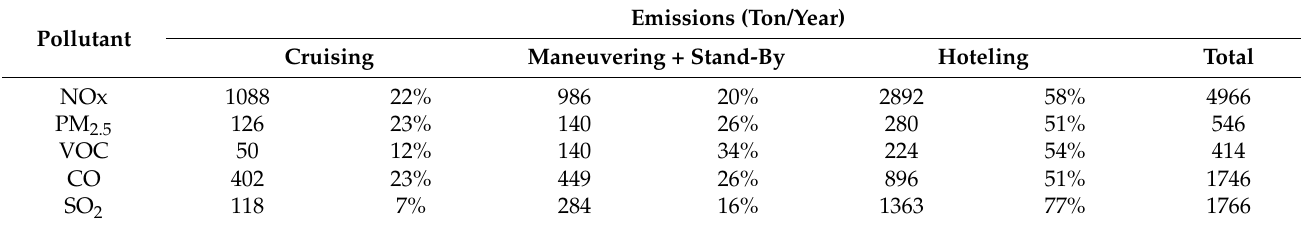
Table A16. Total emissions from vessels (Haifa, MPS A2 2030).